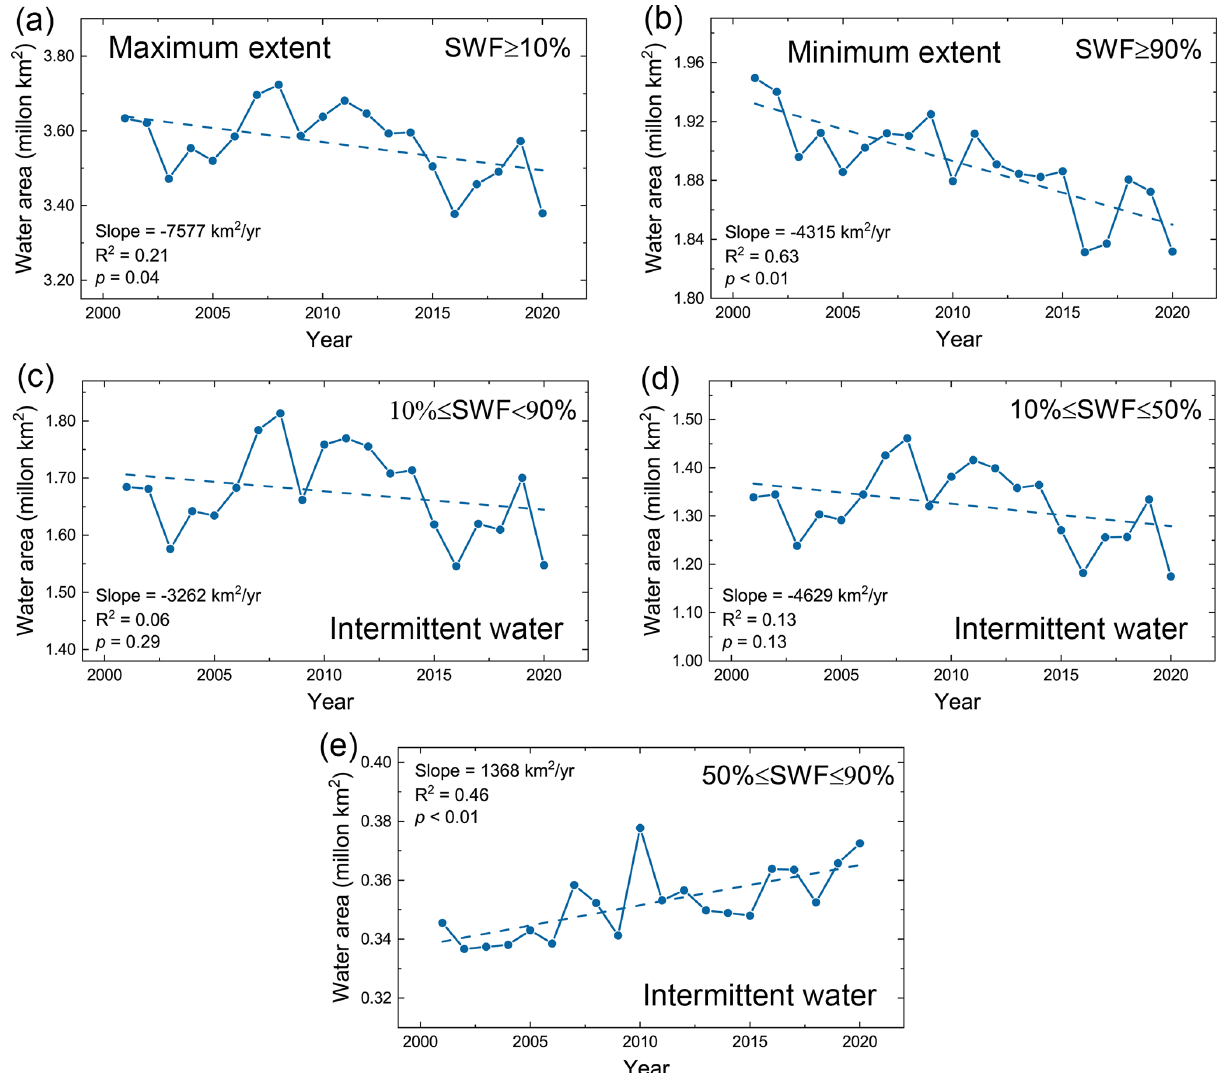
Figure 7. Interannual variation of the area of global surface water with different inundation frequency from 2001 to 2020. (a) Areas of the maximum surface water extent with SWF ≥ 10%. (b) Areas of the minimum surface water extent with SWF ≥ 90%. Areas of the intermittent surface water extent with (c) 10% ≤ SWF < 90%, (d) 10% ≤ SWF < 50% and (e) 50% ≤ SWF <